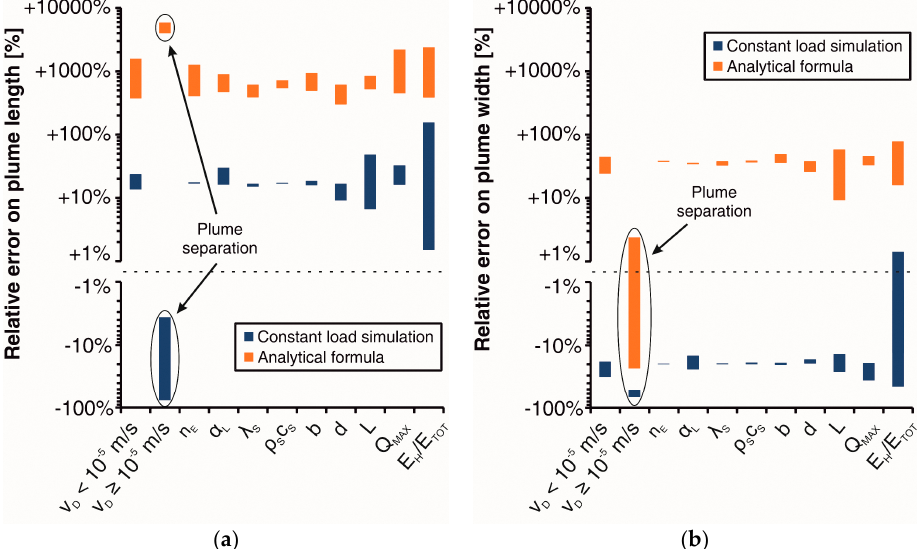
Figure 11. Relative error on plume length ( a ) and width ( b ), evaluated with a constant thermal load simulation and analytical formulae, compared to a variable thermal load simulation, for the considered range of parameters; isotherm ∆ T = 1 °C, t = 50 years.